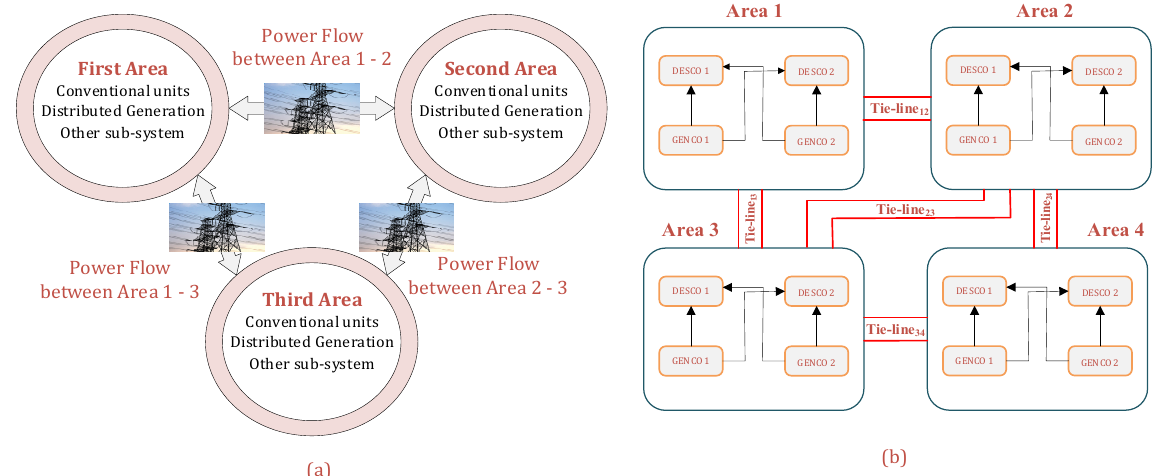
Figure 4. Schematic diagrams for ( a ) three area (conventional) and ( b ) deregulated interconnected power systems. Table 7. Performance evaluation of AGC in Two area deregulated power system under different conditions.